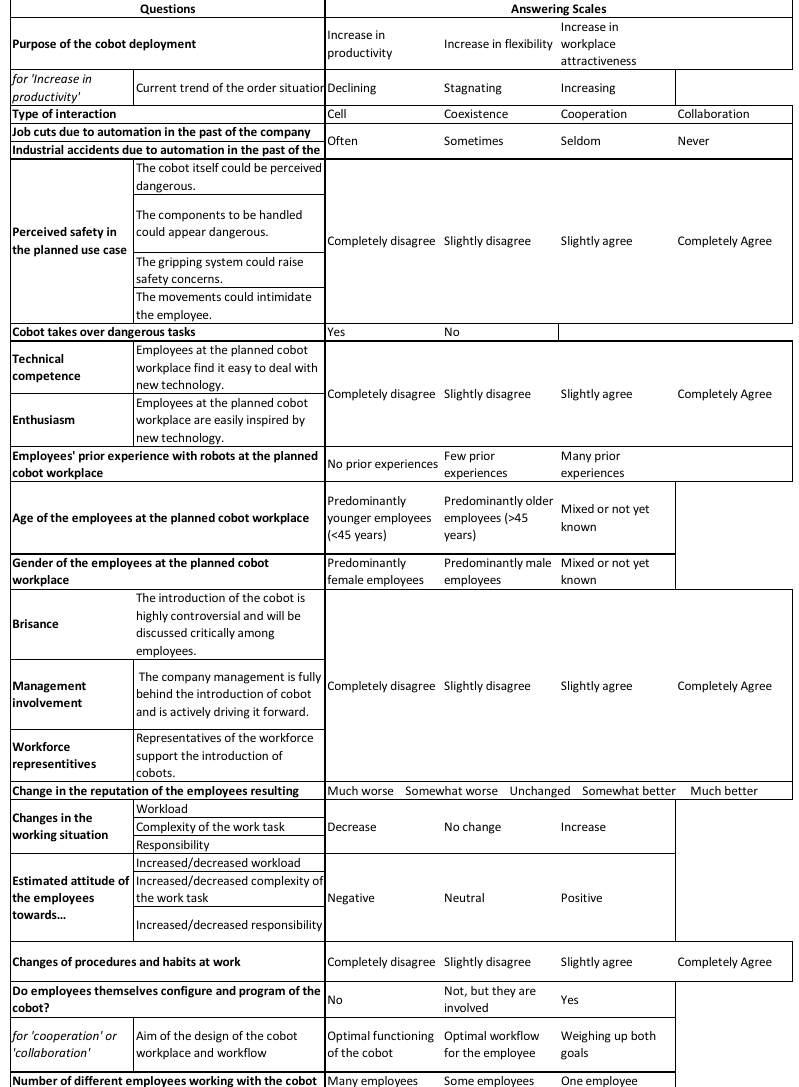
Figure A1. List of queried basic data and respective response scales.